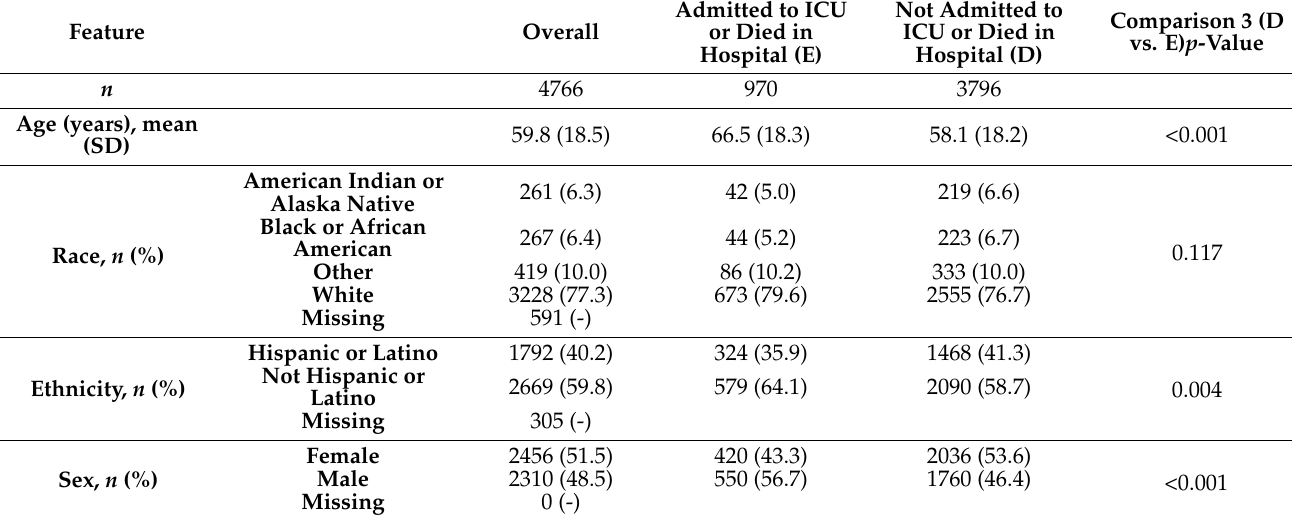
Table A2. Demographic characteristics of non-critical inpatients with and without deterioration outcomes. The “Missing” categories were not included in the calculation of proportions or statistical analysis. SD: standard